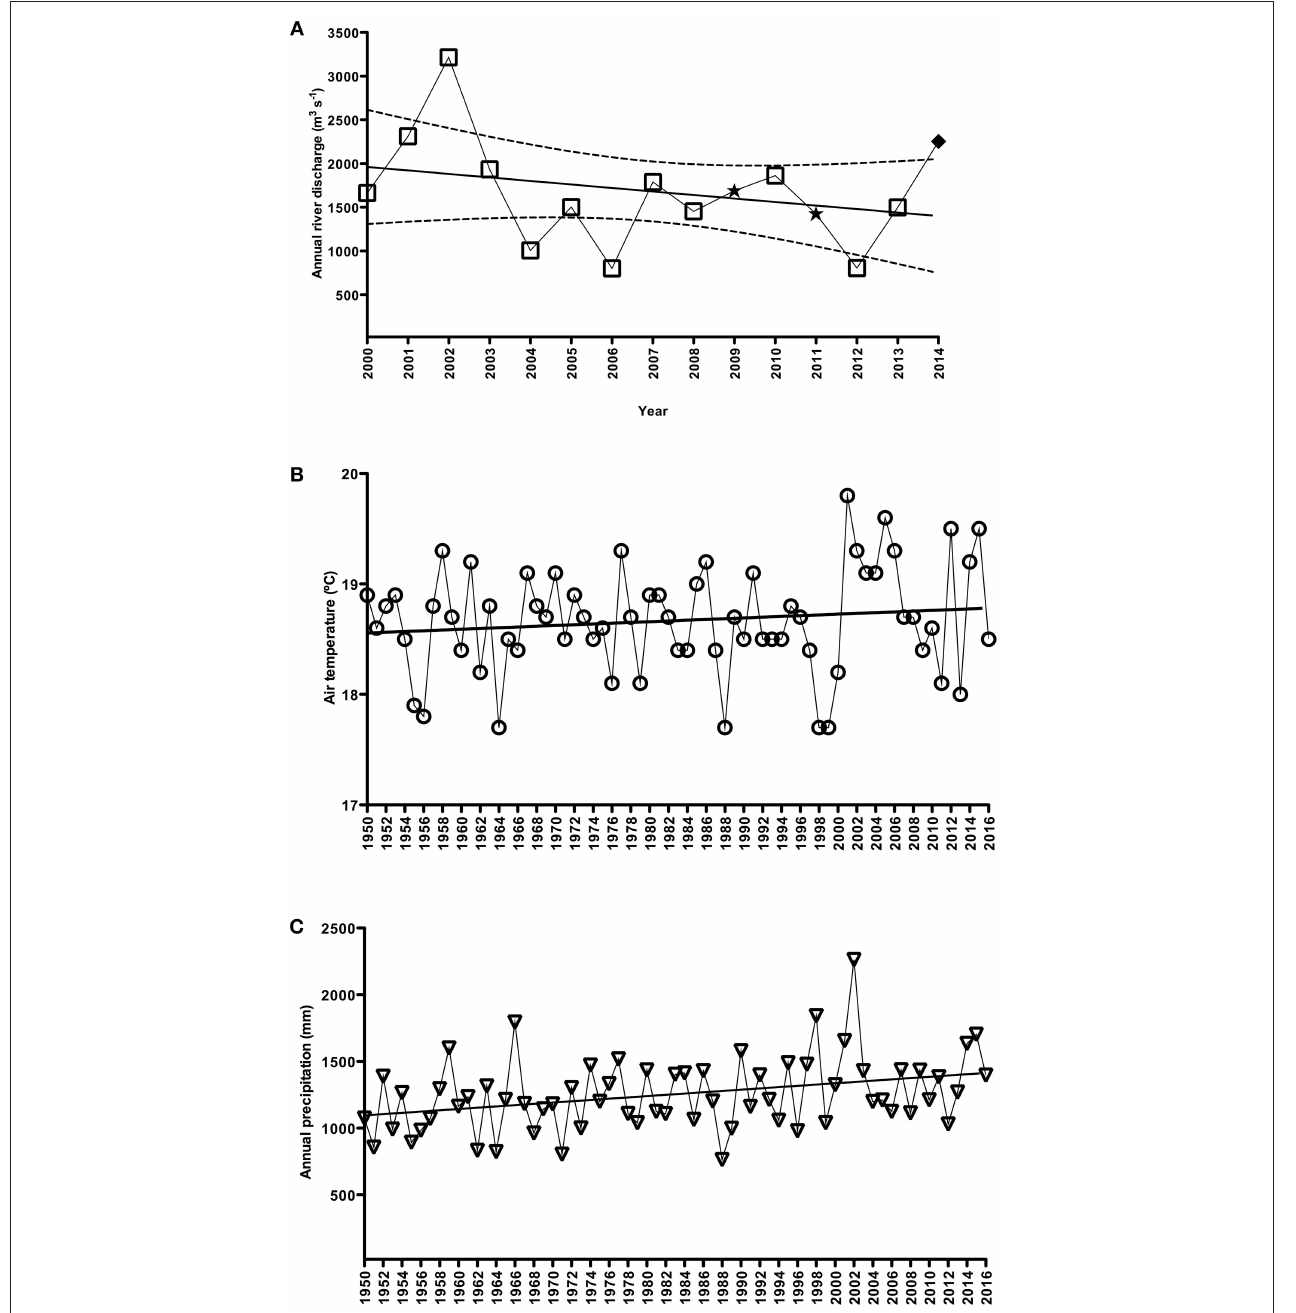
FIGURE 2 | Annual trend (2000–2014) in river discharge (m 3 s − 1 ) (A) of three principal rivers (Jacuí, Taquari and Camaquã) for the Patos Lagoon system, and annual trends (1950–2016) for air temperature ( ◦ C) (B) and accumulated precipitation (mm) (C) based on the Rio Grande meteorological station (INMET, Brazil). Note there are missing data for some particular time periods in Figure 2A as follows: in ( ⋆ ) August–October 2009 for Jacuí river and October 2009 for Taquari river, and March 2011 for the three rivers; and in ( (cid:7) ) November–December 2014 for Camaquã river. Also, note dashed lines referring to 95% confidence intervals in (A) .